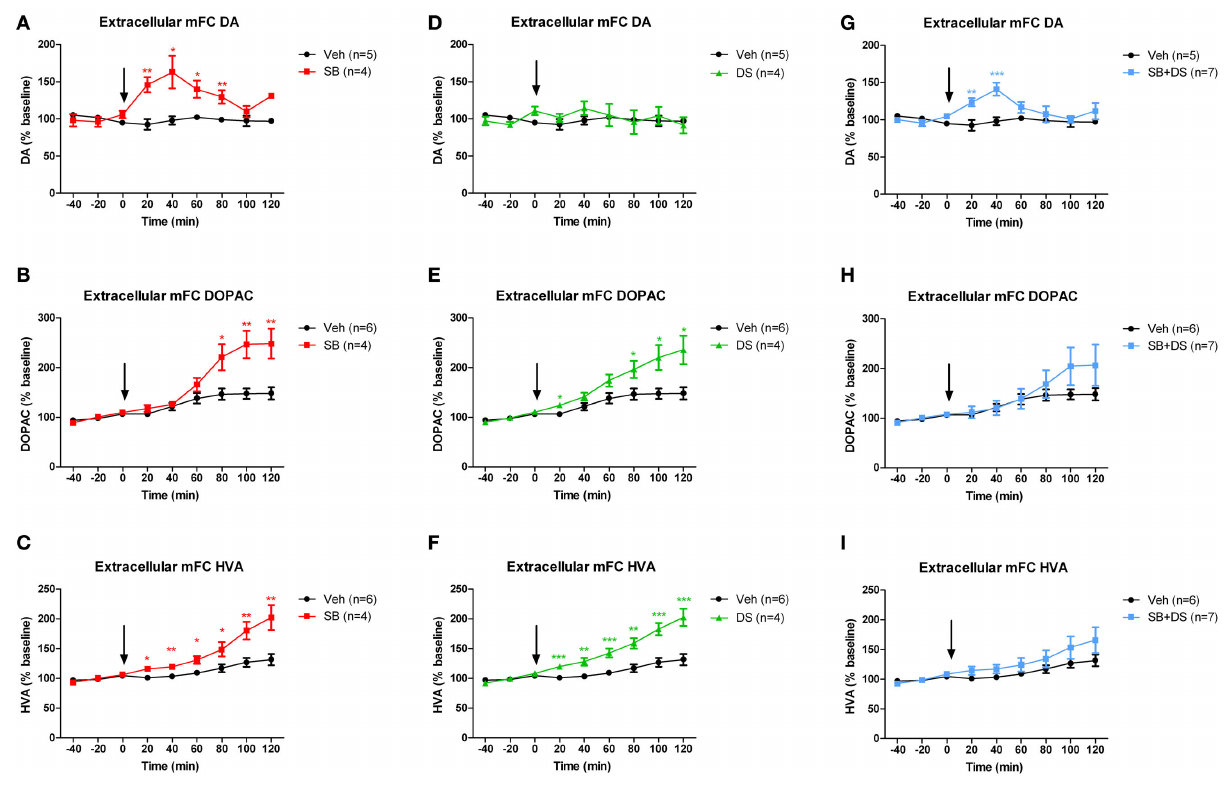
no effect on DA (D) , but increases in DOPAC (E) and HVA (F) . (G–I) Effects of combined sodium benzoate and D-serine, showing increases in DA (G) and no significant change in DOPAC (H) or HVA (I) . The arrow in each panel denotes the time of injection. ∗ p < 0 . 05; ∗∗ p < 0 . 01; ∗∗∗ p < 0 .